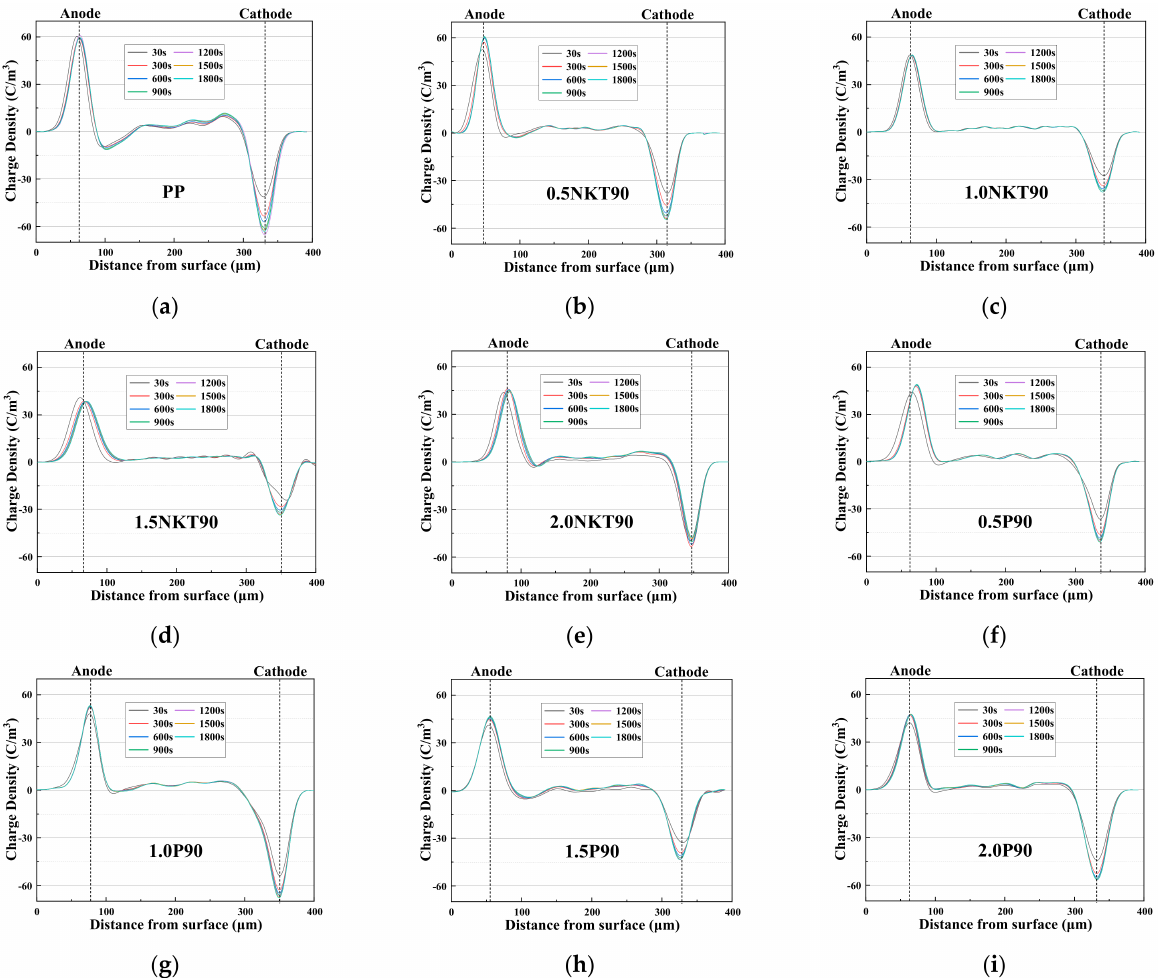
Figure 5. Charge distribution in the polarization phase of nanocomposites. ( a ) PP; ( b ) 0.5NKT90; ( c ) 1.0NKT90; ( d ) 1.5NKT90; ( e ) 2.0NKT90; ( f ) 0.5P90; ( g ) 1.0P90; ( h ) 1.5P90; ( i )